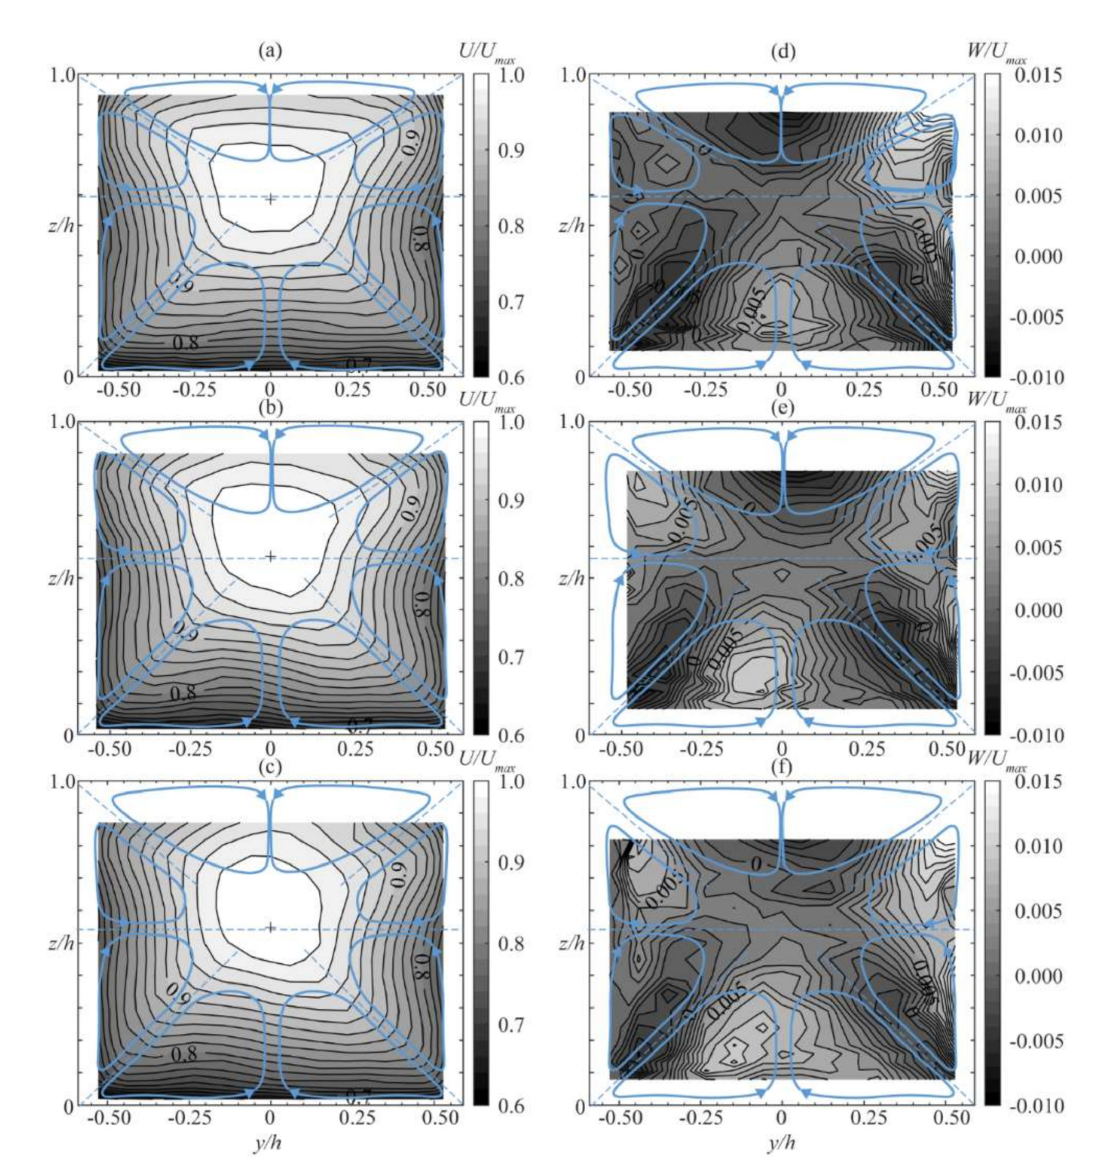
Figure 3. Contour plots of mean normalized flow velocities in ( a – c ) streamwise direction, ( d – f ) vertical direction for